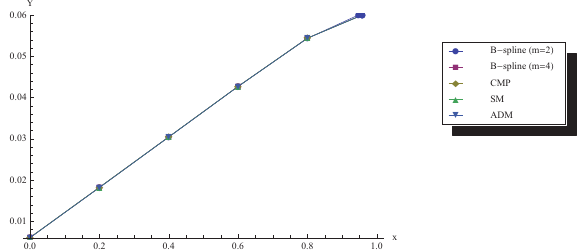
Fig. 1: Numerical results obtained by B-spline wavelet method with the results of other available methods in ref. [2] (for λ = 10 , β = 3 and μ = 0.02 )